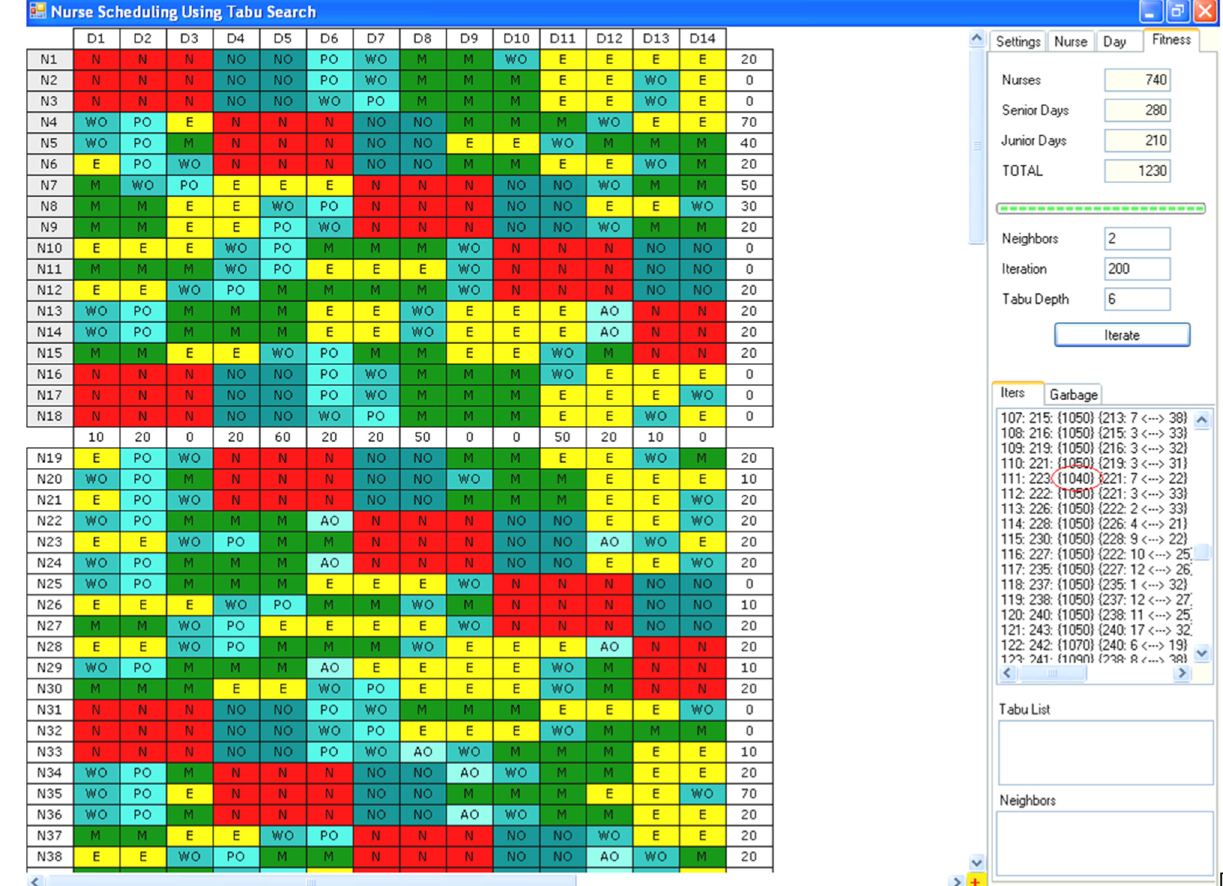
Figure 7. The ‘ best so far ’ schedule